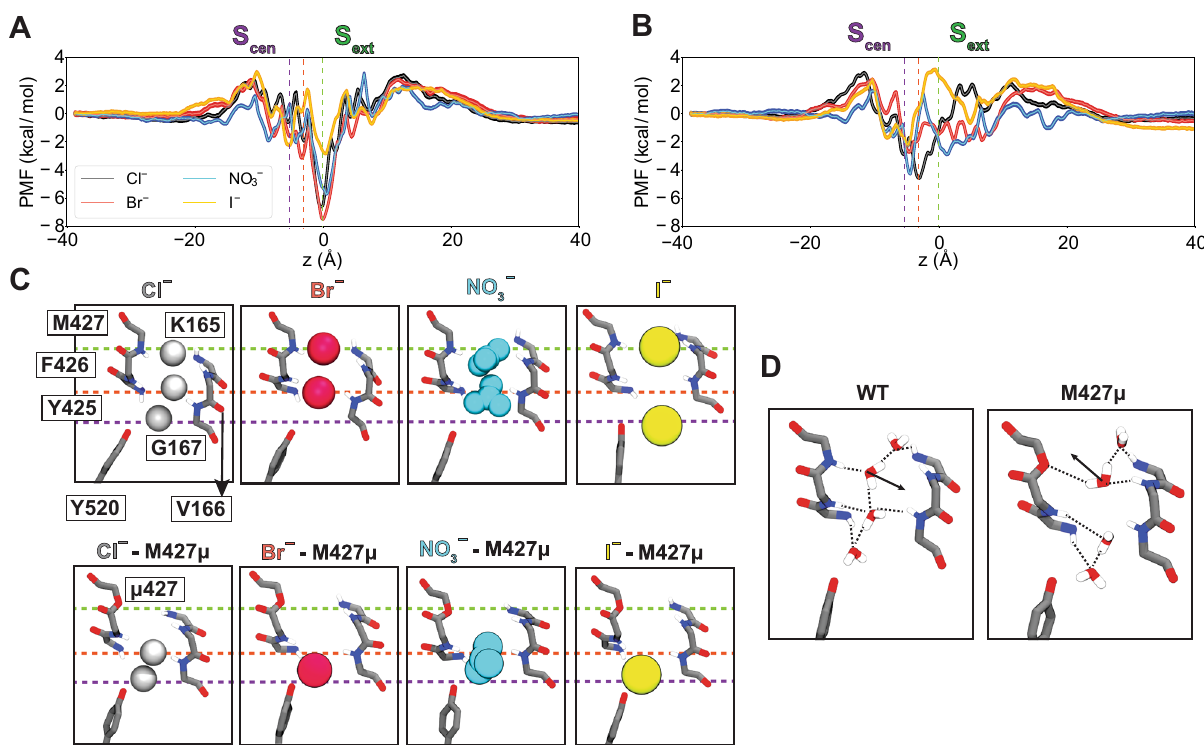
Fig. 5 | Anion-backbone interaction along the permeation pathway in WT and M427 µ bCLC-k. A Single-occupancy PMF calculated along the ion permeation pathway for Cl − , Br − , I − , and NO 3 − in WT bCLC-k. The z positions for the ions are speci fi ed relative to S ext ( z = 0). The positions of S ext , an intermediate binding region, and S cen are indicated by the green, orange, and purple vertical dashed lines, respectively. PMFs are aligned by their energy in the bulk solution. B) Single- occupancy PMF calculated along the ion permeation pathway for Cl − , Br − , I − , and NO 3 − in the M427 μ mutant of bCLC-k. The uncertainty error in ( A ) and ( B ) is